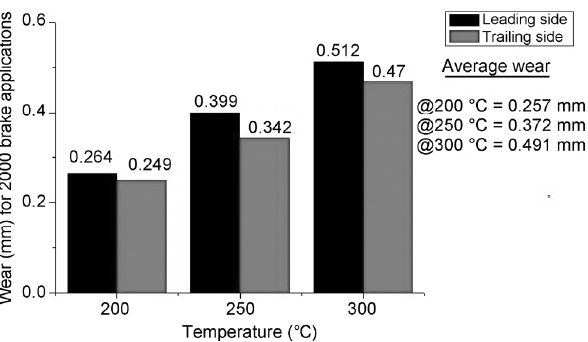
Fig. 5 Wear loss of brake liner in mm at 200 ° C, 250 ° C, and 300 ° C measured in both leading and trailing